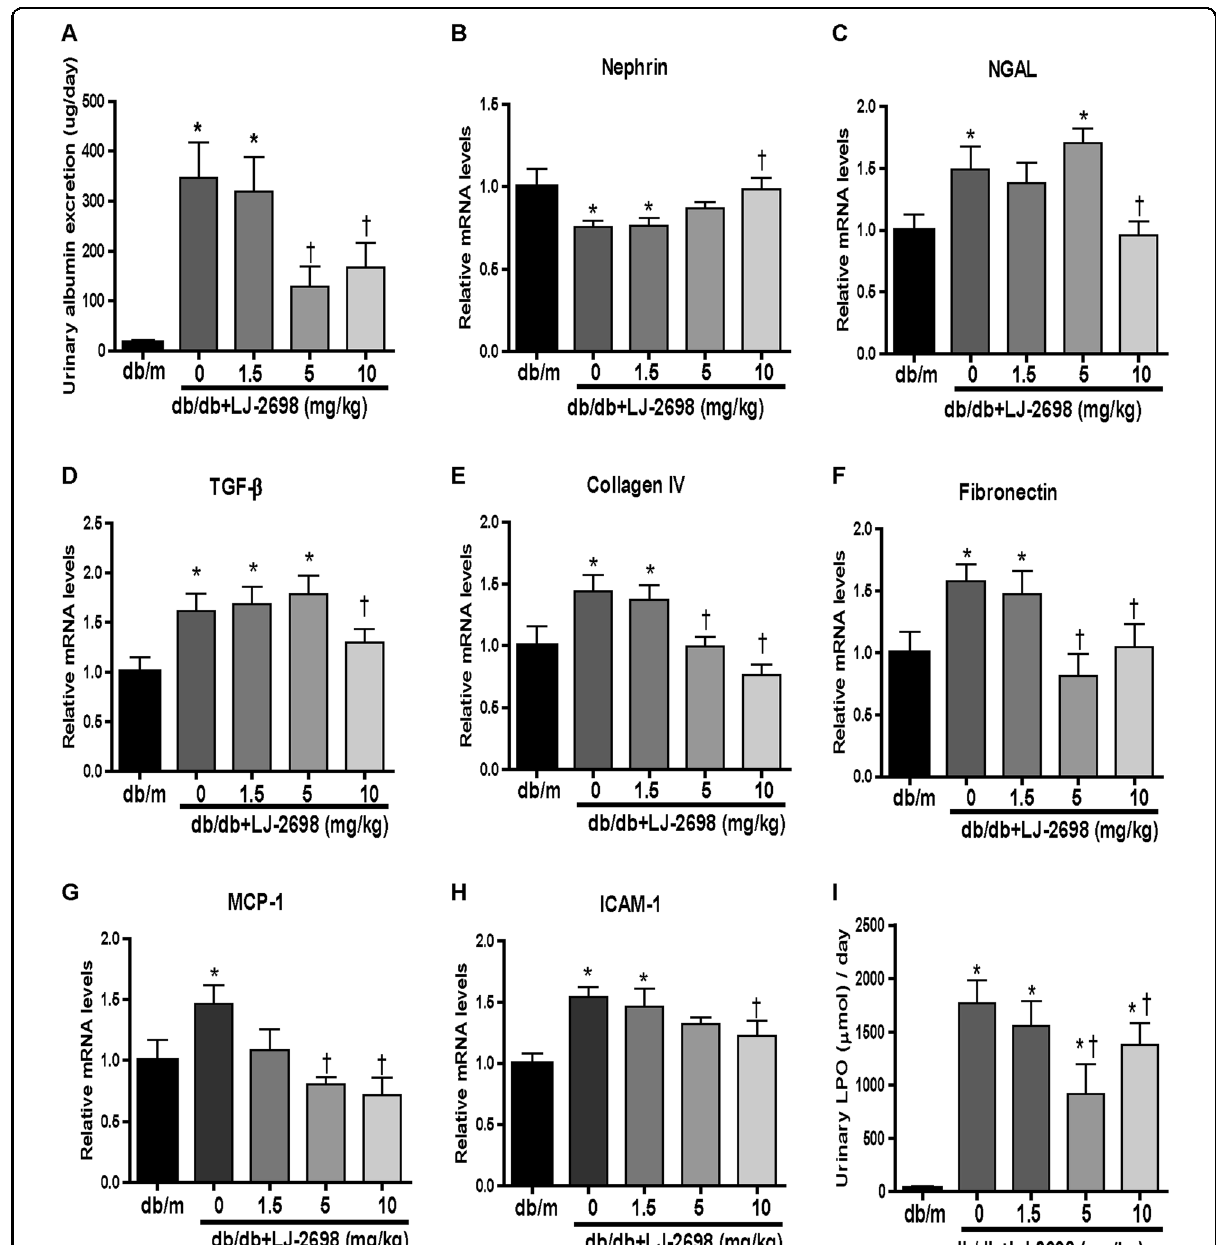
Fig. 3 LJ-2698 exhibited renoprotective effects in a dose-dependent manner in db/db mice. LJ-2698 was administered to db/db mice at doses of 1.5, 5, or 10 mg/kg. CMC was administered to control db/db and db/m mice. After 12 weeks of treatment, ( a ) urinary albumin was measured. mRNA expression levels of ( b ) nephrin, ( c ) NGAL, ( d ) TGF- β , ( e ) collagen IV, ( f ) fi bronectin, ( g ) MCP-1, and ( h ) ICAM-1 were analyzed by qRT-PCR. ( i ) The urinary LPO concentration was measured by the thiobarbituric acid method. Data are presented as the mean ± SE of 7 – 10 mice/group. * p < 0.05 vs. db/m and † p < 0.05 vs. db/db